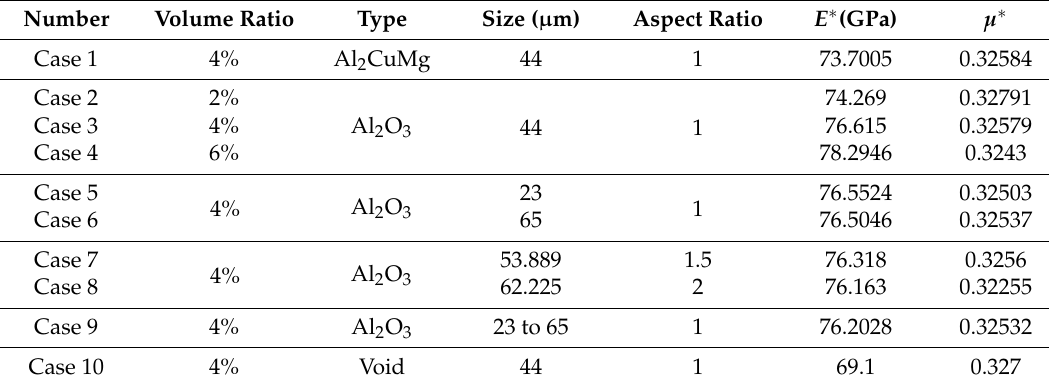
Table 2. All the cases involved in this study.